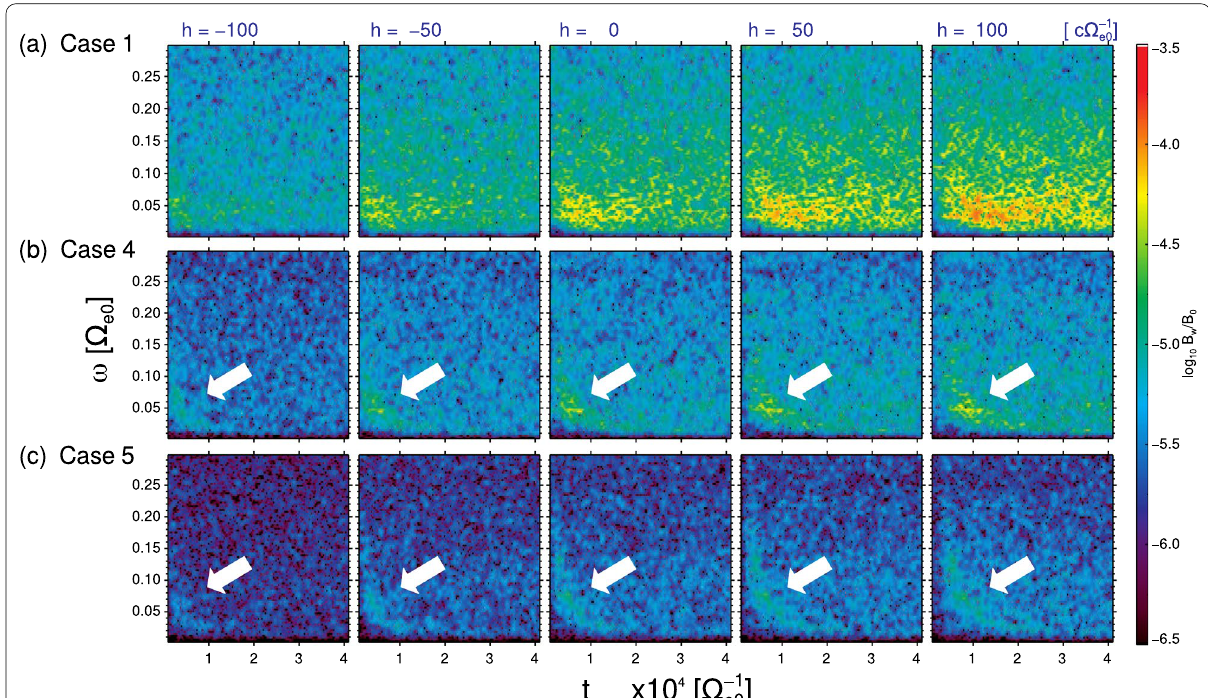
Fig. 10 Dynamic spectra of forward-propagating waves ( t = 0 ∼ 4.2 × 10 4 [ (cid:31) − 1 e 0 ] ) for different hot electron densities( a Case 1 ( ω ph = 0.3 � e 0 ); b Case 4 ( ω ph = 0.15 � e 0 ), and c Case 5 ( ω ph = 0.075 � e 0 )) at locations of h = − 100, − 50,0,50,100 [ c (cid:31) − 1 e 0 ] , respectively. Areas marked with white arrows show similar structures and are analyzed further in Fig.